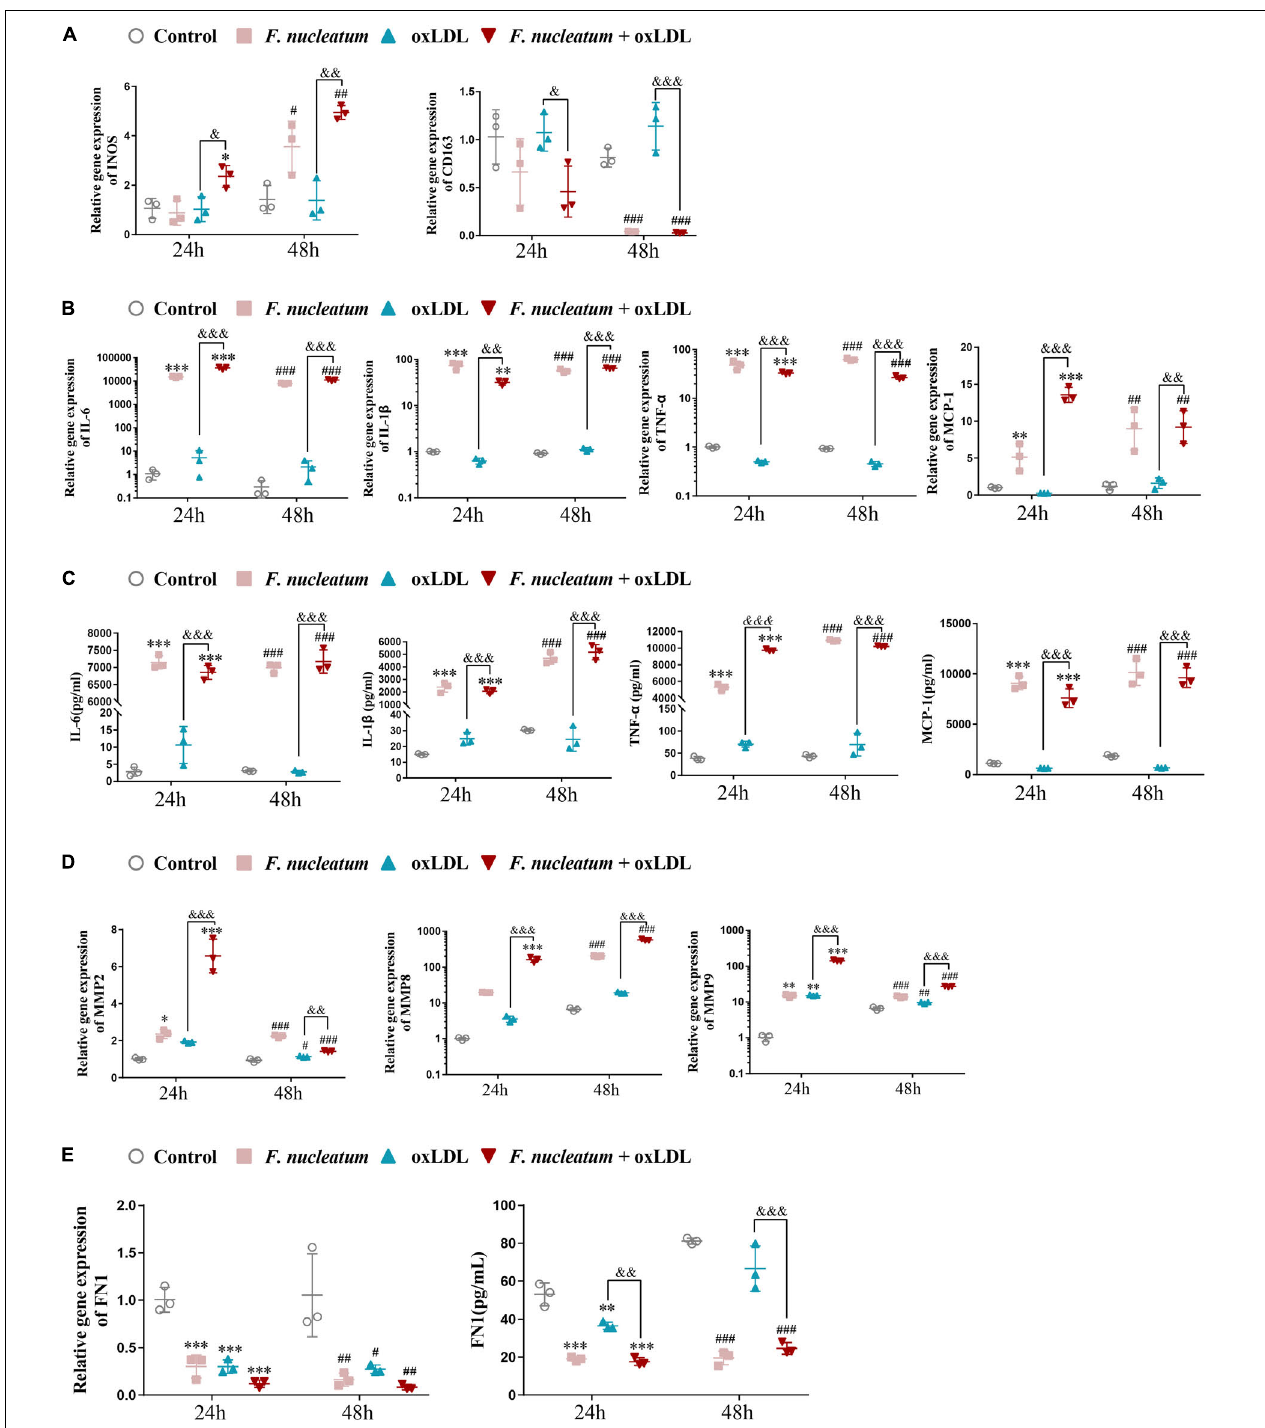
FIGURE 7 | F. nucleatum infection induces M1 macrophage skewing, proinflammatory cytokines, and chemokine production. (A) M1-polarized phenotype marker (INOS) and M2-polarized phenotype marker (CD163) were assessed by qRT-PCR under 24 or 48 h infection at MOI of 100:1. (B) Pro-inflammatory cytokines (IL-1 β , TNF- α , IL-6) and chemokine (MCP-1) were assessed by qRT-PCR. (C) Pro-inflammatory cytokines (IL-1 β , TNF- α , IL-6) and chemokine (MCP-1) were assessed by ELISA. (D) Matrix metalloproteinases (MMP-2, MMP-8, MMP-9) were assessed by qRT-PCR. (E) Extracellular matrix (ECM) protein FN1 were assessed by qPCR and ELISA. The fold change of mRNA was calculated relative to 24 h control group. Data represent the mean ± SD of three duplicates. ∗ p < 0.05, ∗∗ p < 0.01, ∗∗∗ p < 0.001 vs. control group (24 h). # p < 0.05, ## p < 0.01, ### p < 0.001 vs. control group (48 h). & p < 0.05, && p < 0.01, &&& p < 0.001 comparison among groups; The one-way ANOVA with Tukey’s post-hoc